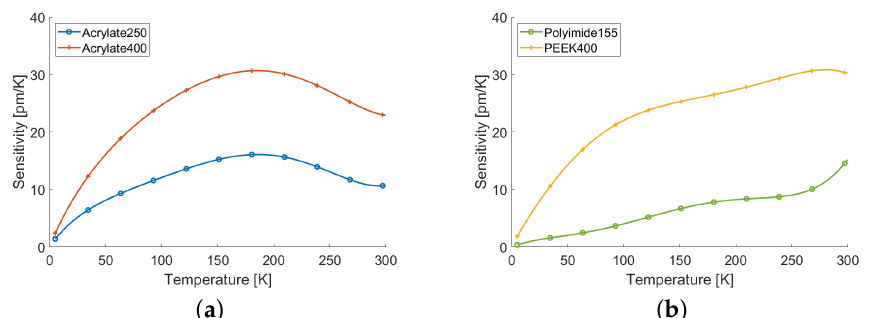
Figure 6. ( a ) Sensitivities of the acrylate-coated fibers. ( b ) Sensitivity of the peek- and polyimide- coated fibers.